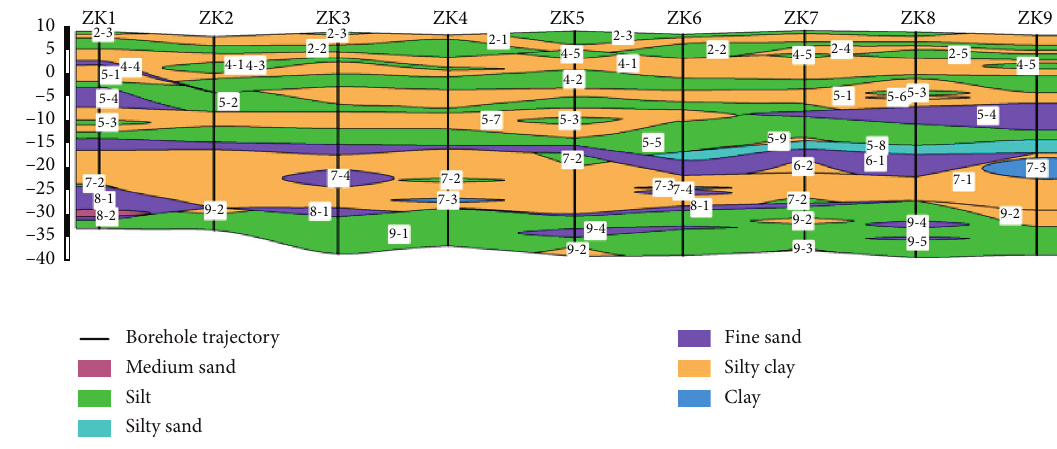
Figure 11: The engineering section drawn by geologist knowledge on a regional scale.